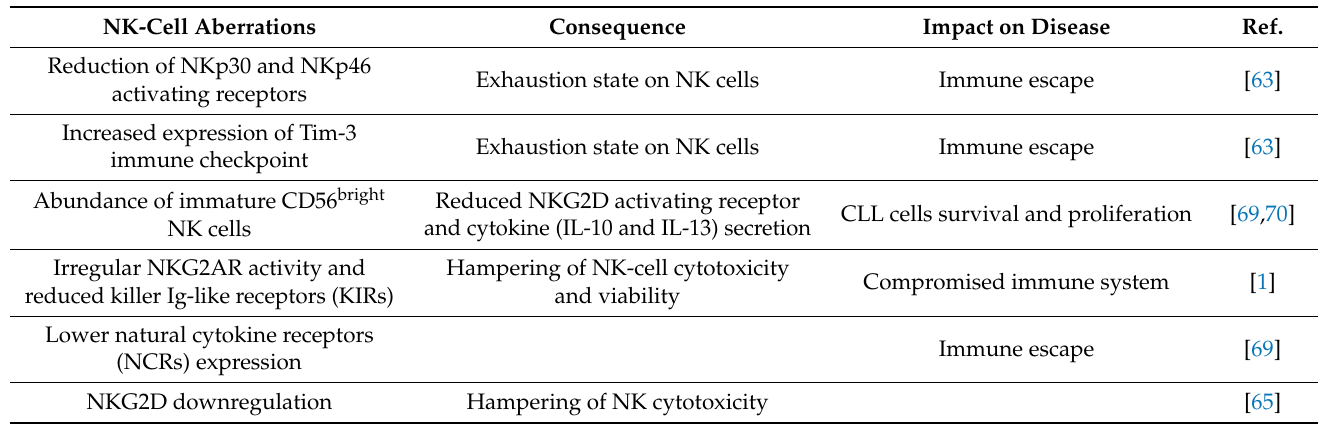
Table 1. Relevant qualitative NK-cell aberrations reported in patients with